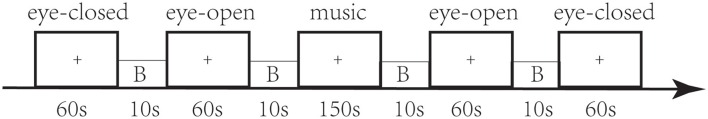
Experimental protocol used in our study. All subjects were asked to keep their eyes closed for 1 min without thinking about anything, and after a short break (B = Break), they kept their eyes fixed on the “+” in the middle of the screen for 1 min. After 2 min in the resting state, there was two and half minutes of music playing; subjects were asked to keep their eyes closed and listen quietly without thinking about anything. Next, there was 1 min with eyes open, followed by 1 min of eyes closed, and then the experiment was complete.